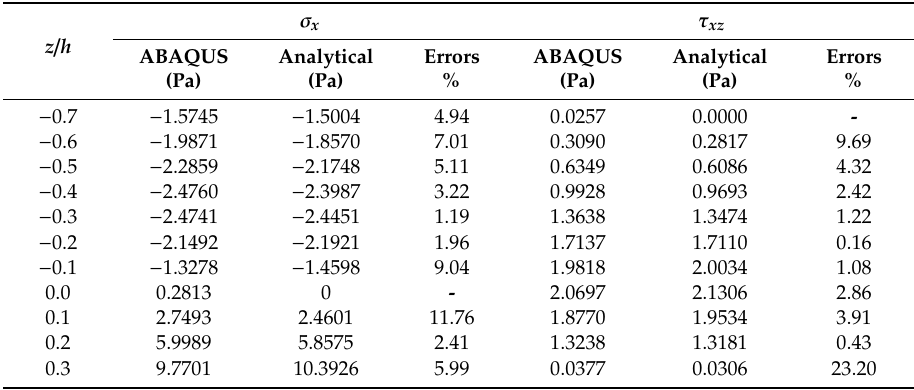
Table 4. Relative errors of two solutions of σ x and τ xz ( x = 0.25 l